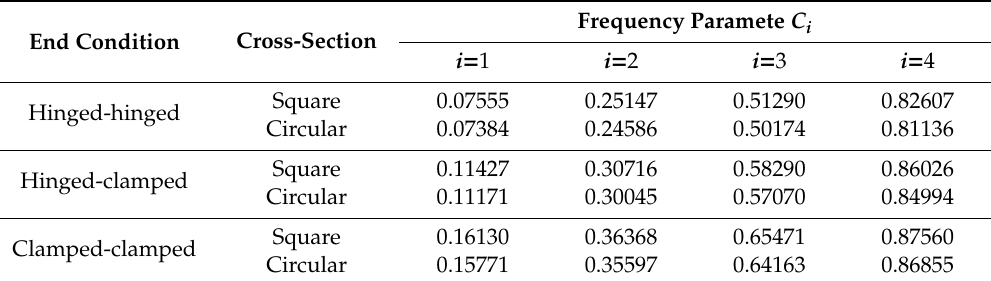
Table 3. E ff ect of cross-sectional shape on frequency parameter C i